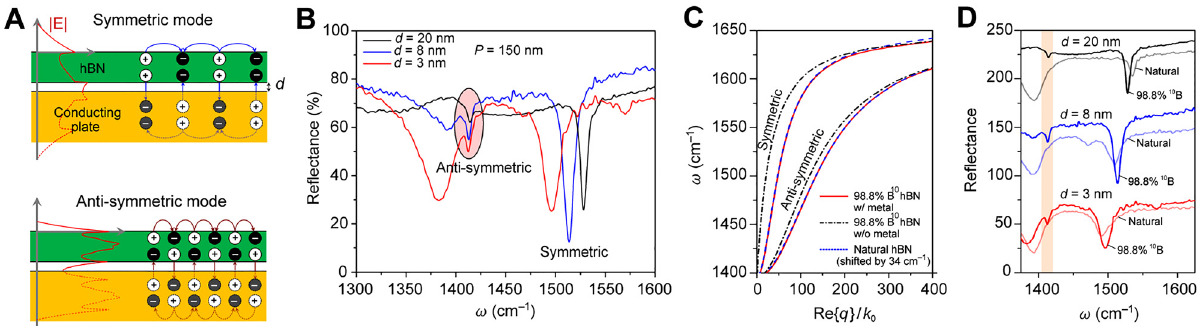
Figure 8: Far-field probing of the image phonon-polaritons in hBN. (A) Charge distribution of the symmetric and anti-symmetric image modes in hBN separated from gold layer by a thin alumina spacer of thickness d . (B) Re fl ectance spectra of the isotopically enriched h 10 BN deposited on the resonator structure with the optical cavity shown in Figure 6A, for different alumina thickness d and the same period P of the nanoribbons. (C) Calculated dispersion of the symmetric and anti- symmetric image modes in hBN of the two isotopic compositions: naturally abundant (blue) and isotopically enriched (red); the black dot- dashedline indicatesthedispersionof afree-standingisotopicallyenrichedhBNslab.(D)Re fl ectancespectraoftheresonatorswithdifferent alumina thickness, measured for natural and isotopically enriched hBN samples; the shaded resonance peak corresponds to the high-index anti-symmetricmode,presentonlyintheisotopicallyenrichedh 10